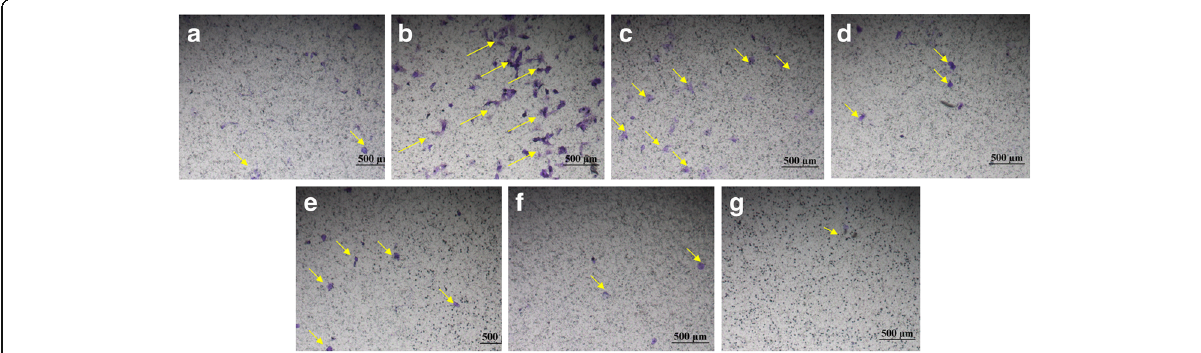
Fig. 9 KFX and positive control promote BMSCs migration. The migration properties of BMSCs are measured using a transwell migration assay. a Blank control (untreated), b KFX (0.1 mg/mL), c KFX (1 mg/mL), d KFX (5 mg/mL), e PC substance (0.1 mg/mL), f PC substance (1 mg/mL), g PC substance (5 mg/mL). Migrating BMSCs are indicated by yellow arrows. Scale bar = 500 μ m. Obvious migration was observed for BMSCs after treated with KFX (0.1